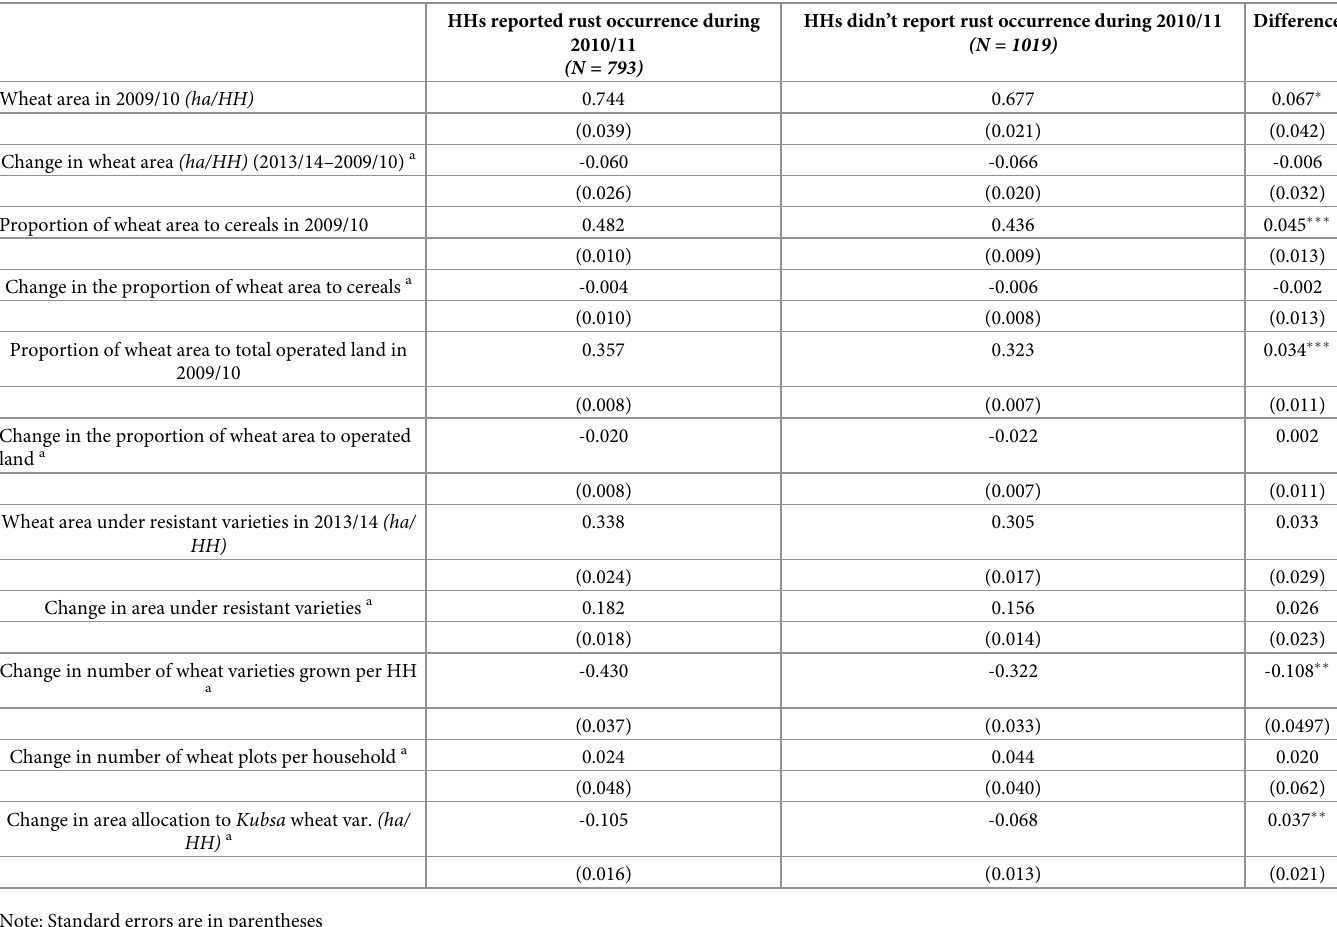
Table 5. Selected indicators of households by reported wheat rust occurrence in 2010/11 season, Ethiopia (2009/10 and 20013/14